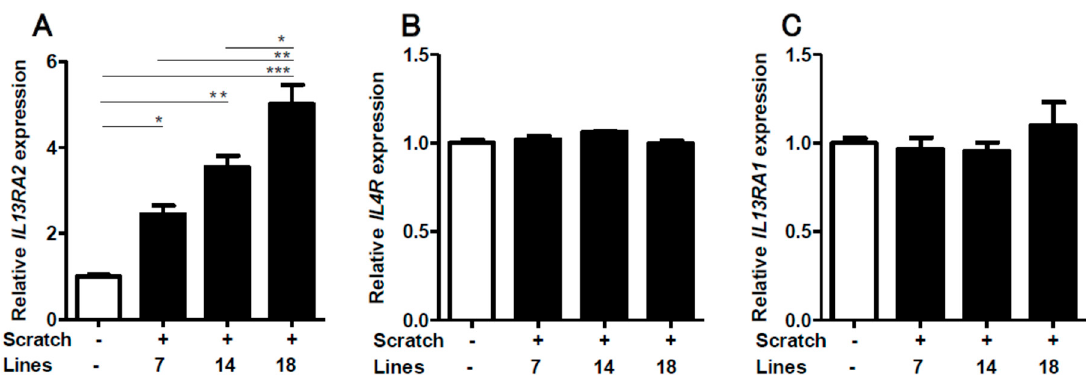
Figure 3. Scratching upregulated IL13RA2 expression in a scratch line number-dependent manner. The keratinocyte sheet was scratched with 7, 14, and 18 scratch lines, and the gene expression of IL13RA2 ( A ), IL4R ( B ), and IL13RA1 ( C ) was measured ( n = 3) 6 h after scratching. Data is shown as the mean ± SEM. * p < 0.05, ** p < 0.01, *** p < 0.001.